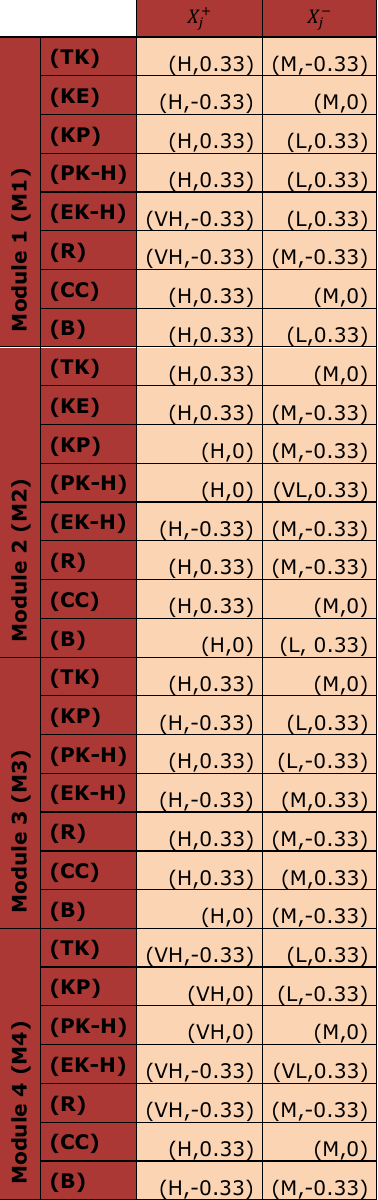
Table 4. The 2-tuple positive and negative ideal solution ( and )